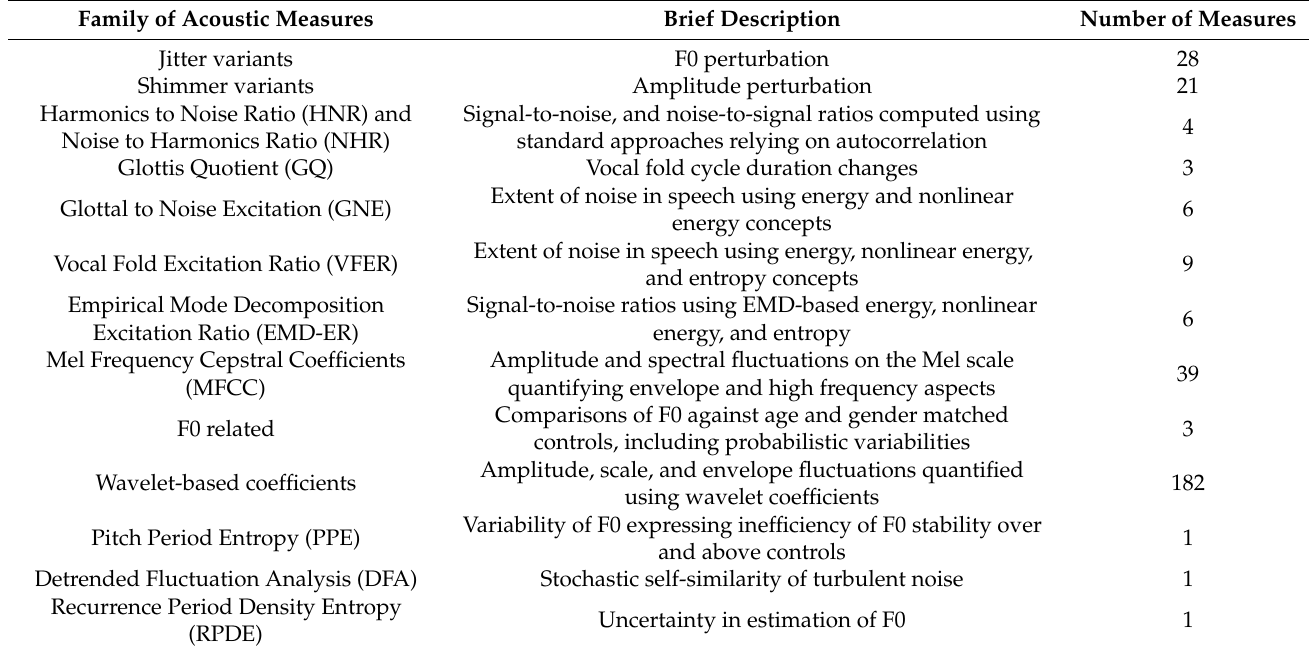
Table 2. Breakdown of the dysphonia measures used in the